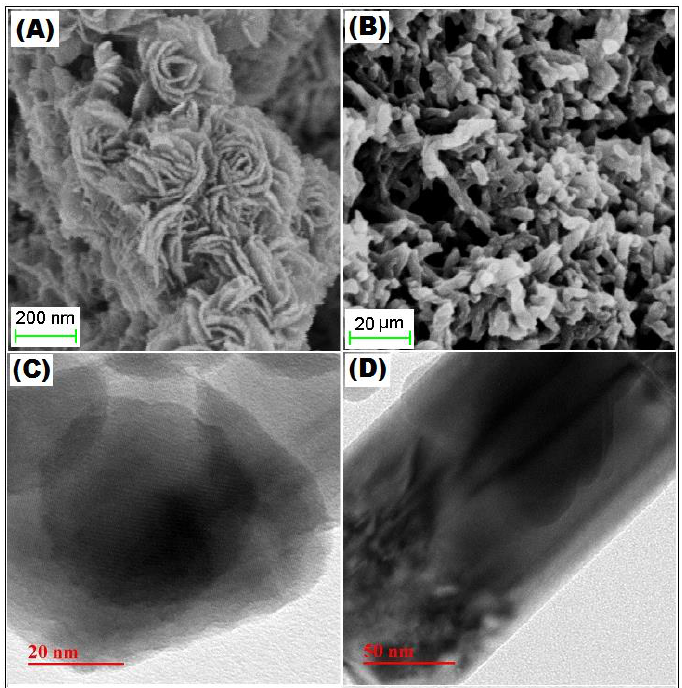
Figure 1. Scanning electron microscope image of ( A ) bare MoS 2 ; ( B ) polyaniline / molybdenum disulfide hybrid nanomaterial (PANI-MOS 2 ); and transmission electron microscopy image of ( C ) MoS 2 ; and ( D ) PANI-MOS 2